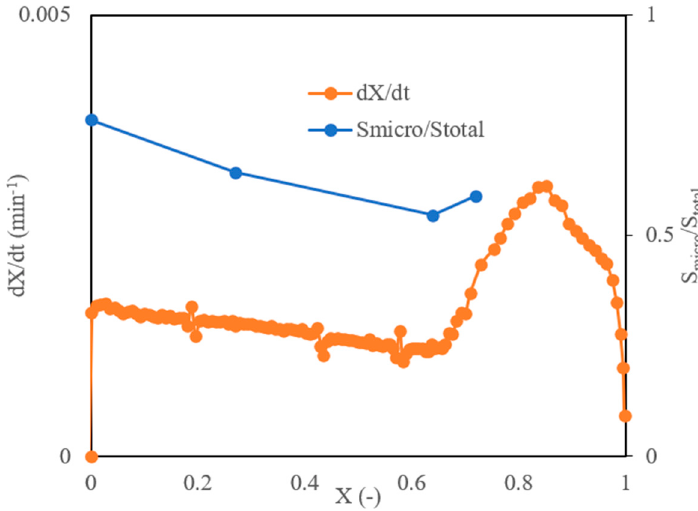
Figure 2. Micropores development and its reactivity at 700 °C.